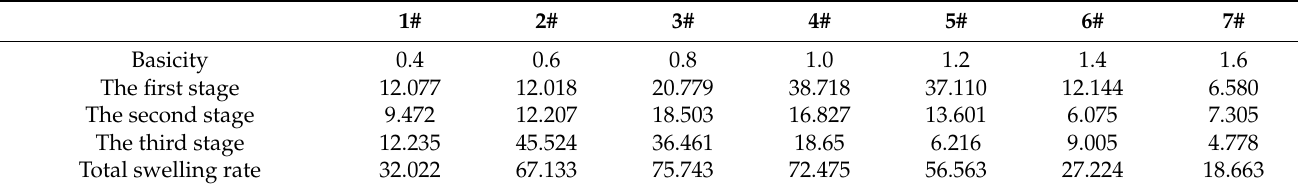
Table 5. Reduction swelling data of pellets with different basicities at different stages/%.